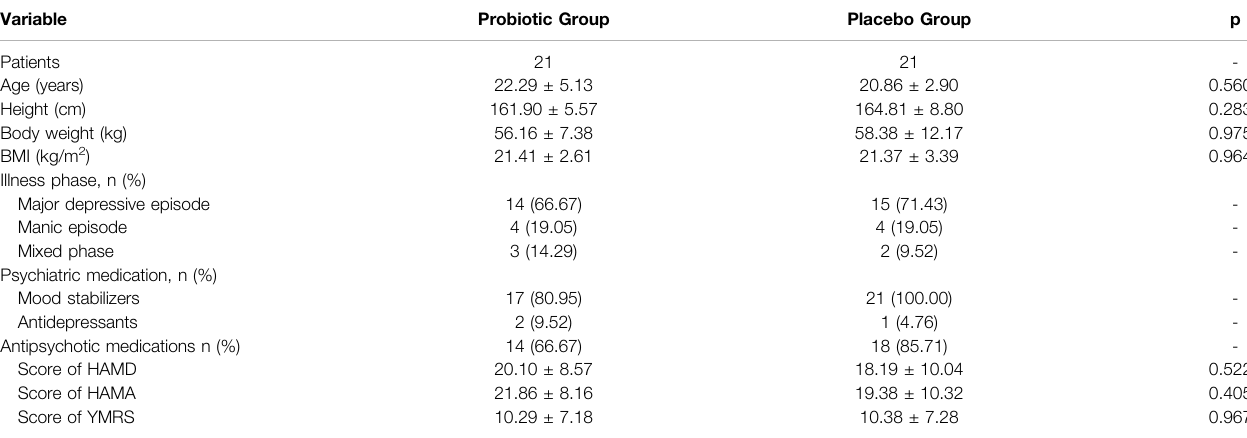
TABLE 1 | Baseline characteristics of the study participants. Variable Probiotic